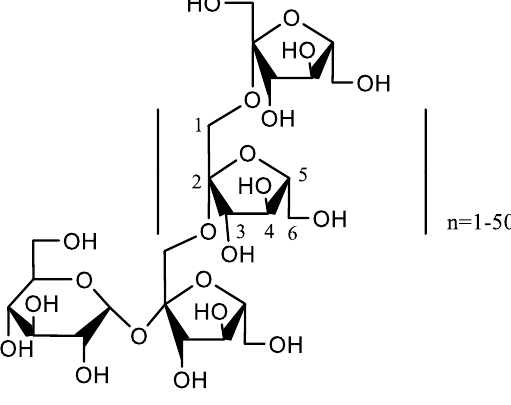
Figure 1. Chemical structure of inulin.